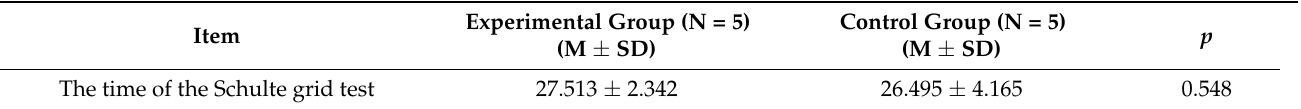
Table 2. The Schulte grid test comparison between the experimental group and the control group before the experiment.